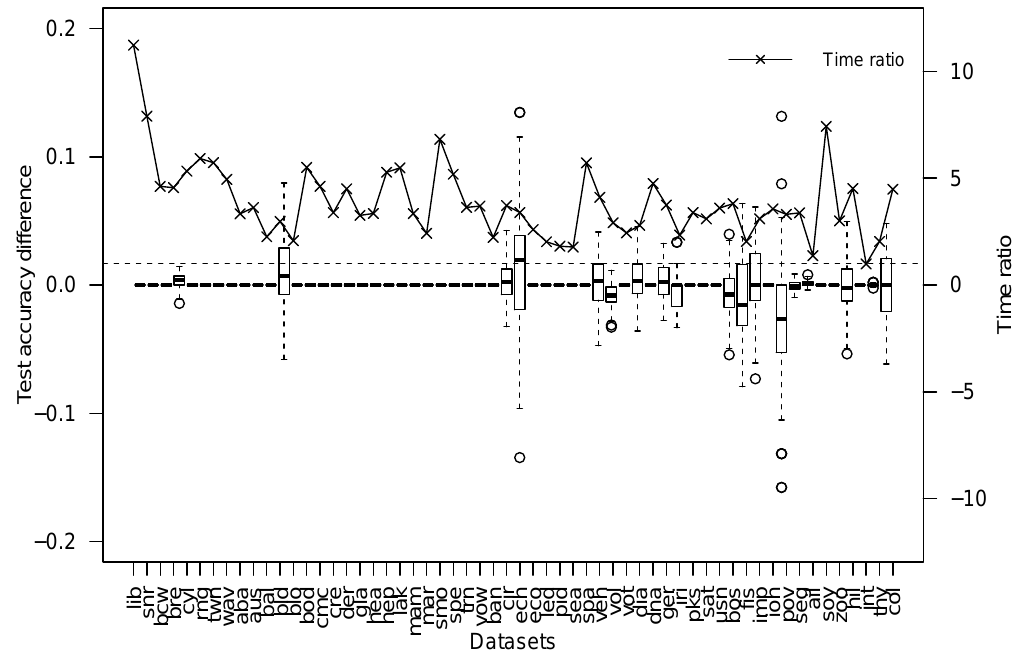
Figure 8. Confidence intervals of accuracy differences and the ratio of computing times between the proposed method and the grid search